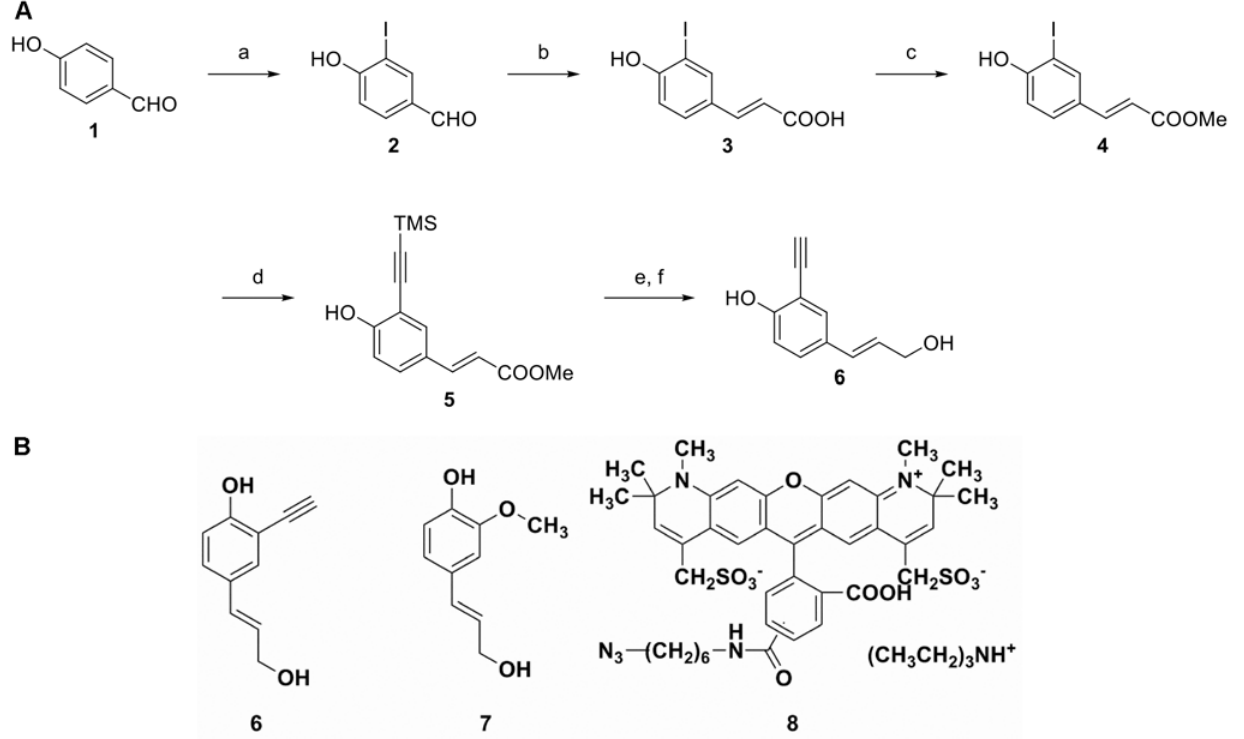
Fig 1. Synthesis of 3-ethynyl p- coumaryl alcohol (3-EPC), 6. (A) Reagents and conditions: a) Iodine monochloride, acetic acid, dichloromethane, 24 hours, 25°C; b) malonic acid, pyridine, piperidine, 90°C, 3.5 hours; c) methanol, sulfuric acid, reflux, overnight; d) trimethylsilyl acetylene, Bis (triphenylphosphine)palladium(II) chloride, cuprous iodide, triethylamine-tetrahydrofuran, 50°C, overnight; e) Diisobutylaluminium hydride (DIBAL-H), dichloromethane, -78°C, 3 hours; f) tetrabutylammonium fluoride, tetrahydrofuran, 25°C, 1 hour. (B) Chemical structures of monolignols and fluorophore. (E)- 2-ethynyl-4-(3-hydroxyprop-1-enyl)phenol or 3-ethynyl p- coumaryl alcohol (3-EPC), 6 , the monolignol probe developed in this paper; coniferyl alcohol (CA), 7 , a natural lignin monomer; and Alexa 594-azide, 8 , for fluorescence imaging.